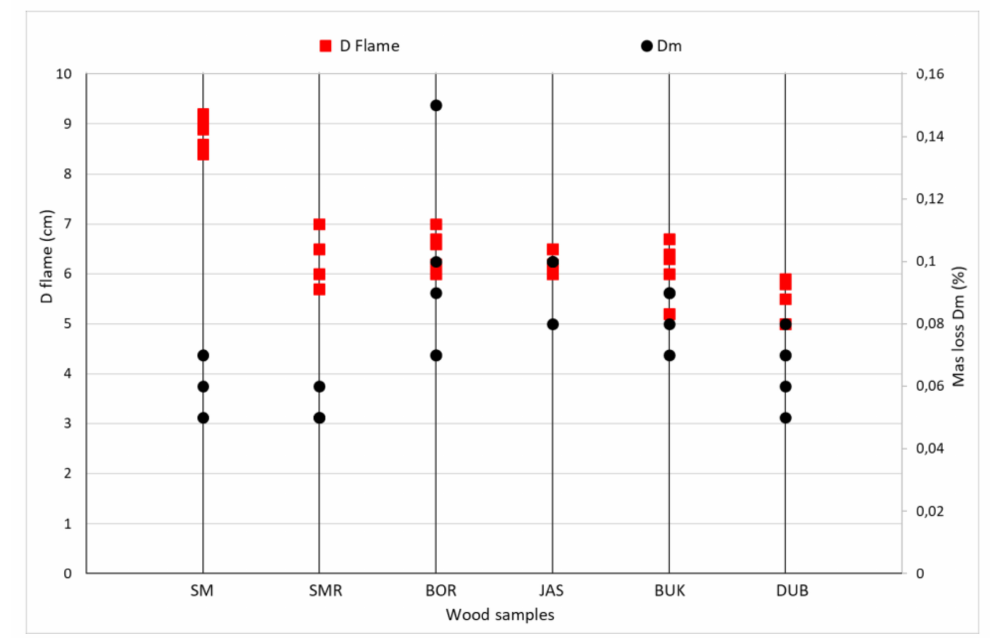
Figure 4. Dependence of mass change after application of a small flame initiator for 30 s and comparison of flame height for each wood